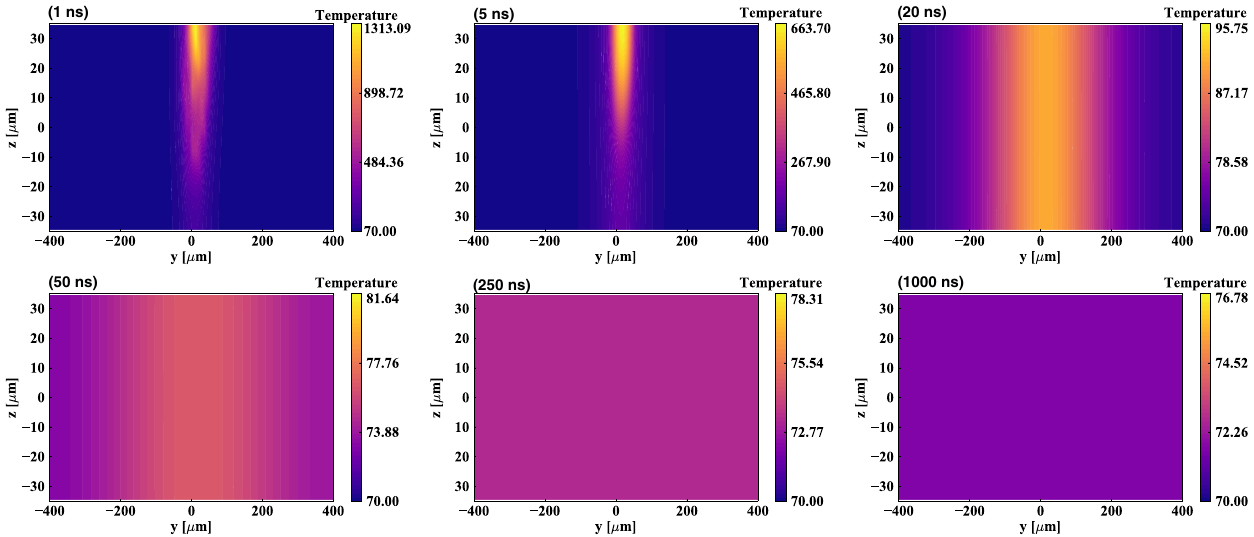
FIG. 8. Snapshots of temperature field calculated with a single-pulse input. It can be seen that the early temperature is much higher on the incident surface, and the highest temperature drops rapidly to 95 K within 20 ns. At 20 ns, it can be found that the temperature along the thickness becomes homogeneous. The temperature is nearly uniform throughout the entire crystal at 250 ns and drops to about 71.8 K at 1000 ns.